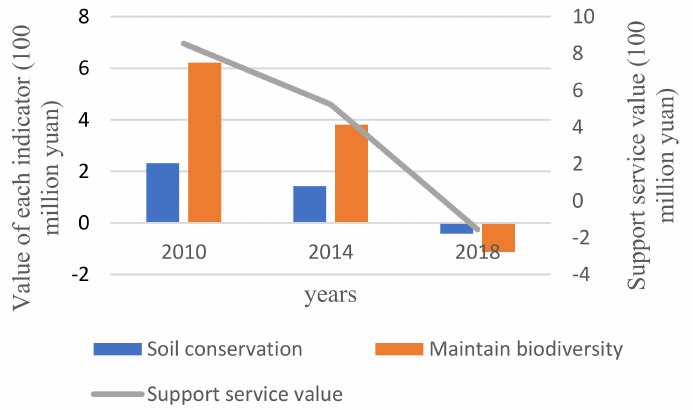
Figure 6. Support service